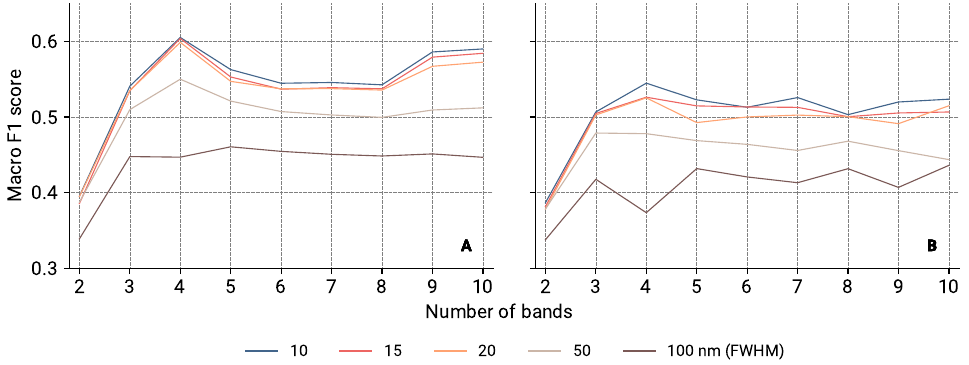
Figure 12. Macro F1 scores using different numbers of channels as derived from the feature selection and in dependence of different FWHM, while ( A ) was classified with k-NN and ( B ) with